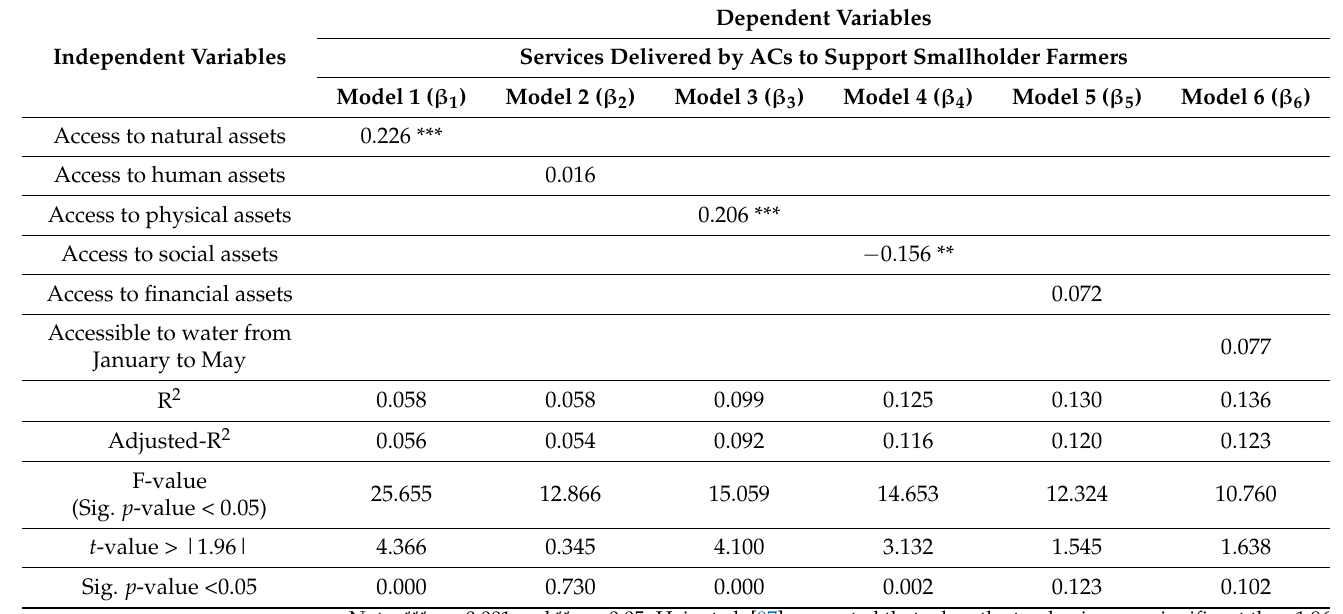
Table 4. Services delivered by ACS to support smallholder